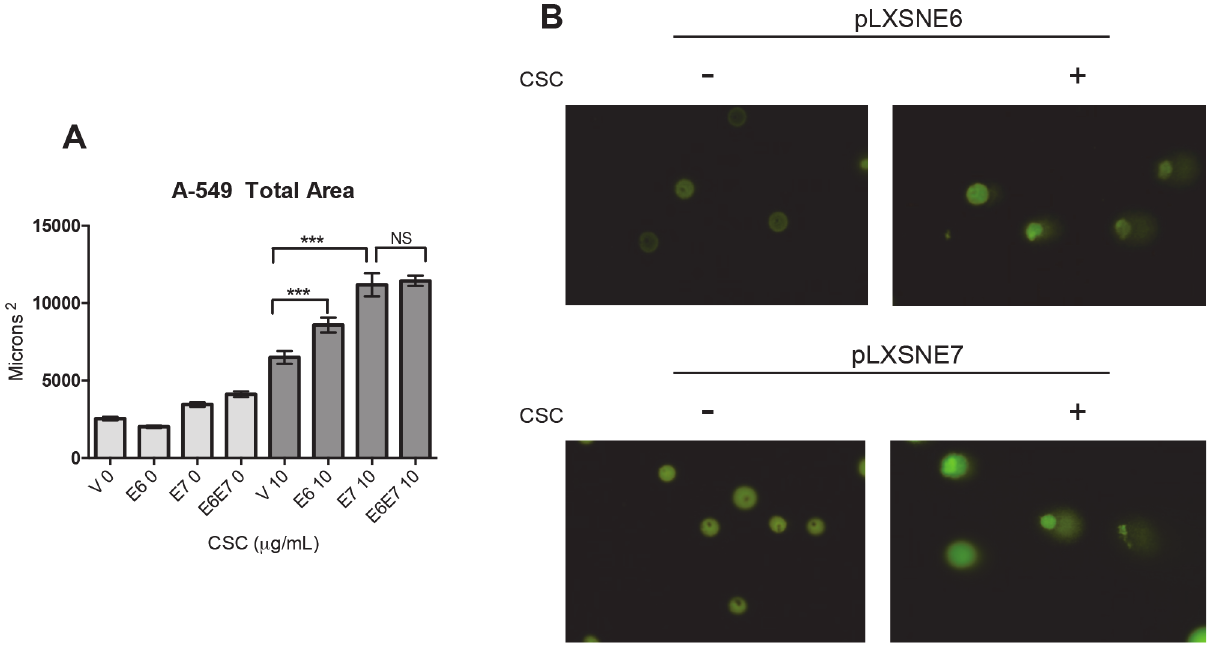
Fig 5. HPV-16 E6 and E7 oncogenes independently are able to sensitize cells to DNA damage. (A) A-549 cells expressing HPV-16 E6 or E7 oncogenes were exposed to CSC at 10 μ g/mL and DNA damage was evaluated using Comet Assay. (B) Image showing comets in A-549 cells transfected with pLXSNE6 (upper) or pLXSNE7 (below) in the presence or absence of CSC. ( *** = p < 0.001, Total Area ±